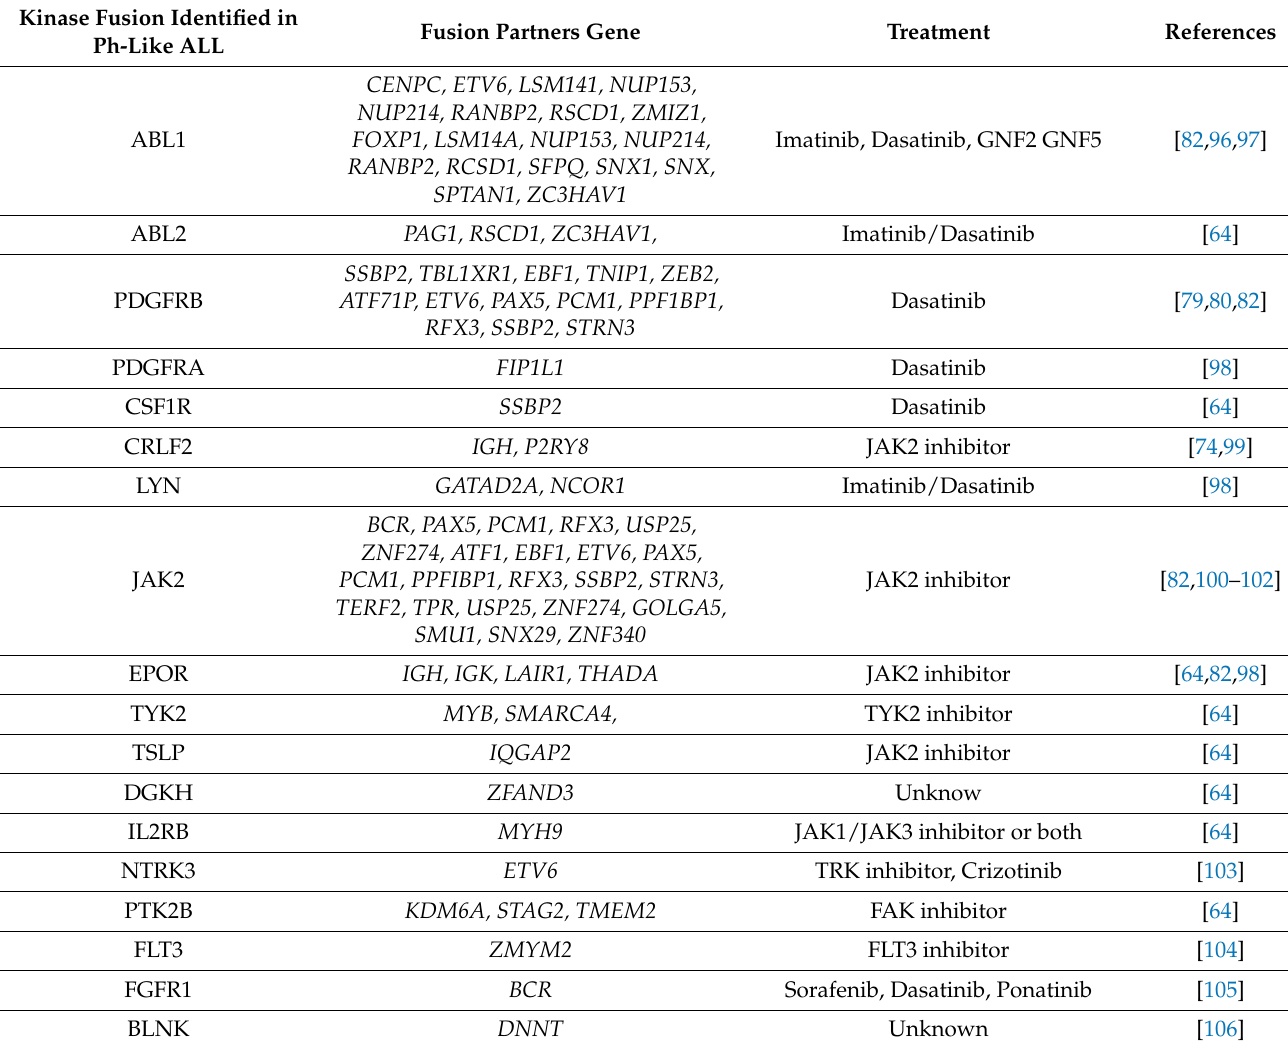
Table 2. Kinase fusion and partner genes identified in Ph-like ALL, and therapy